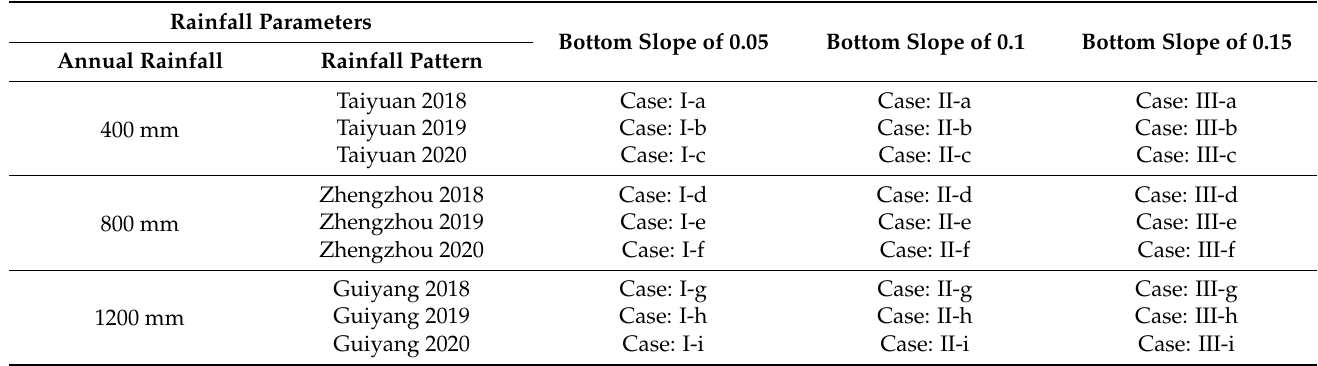
Table 1. Calculation table of working conditions. Rainfall Parameters Bottom Slope of 0.05 Bottom Slope of 0.1 Bottom Slope of 0.15 Annual